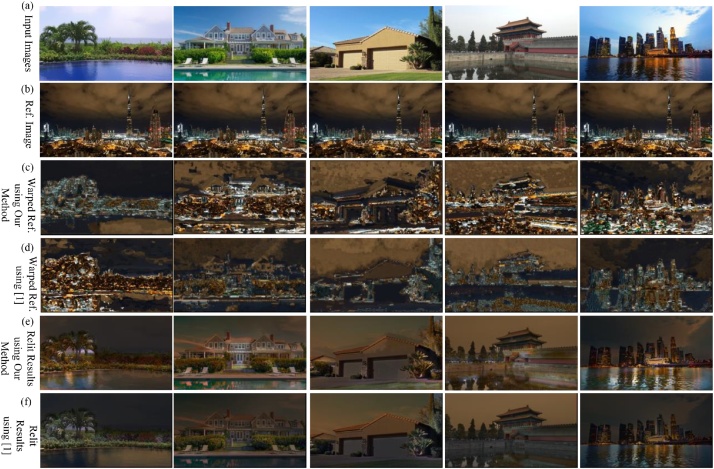
Comparison with [4].